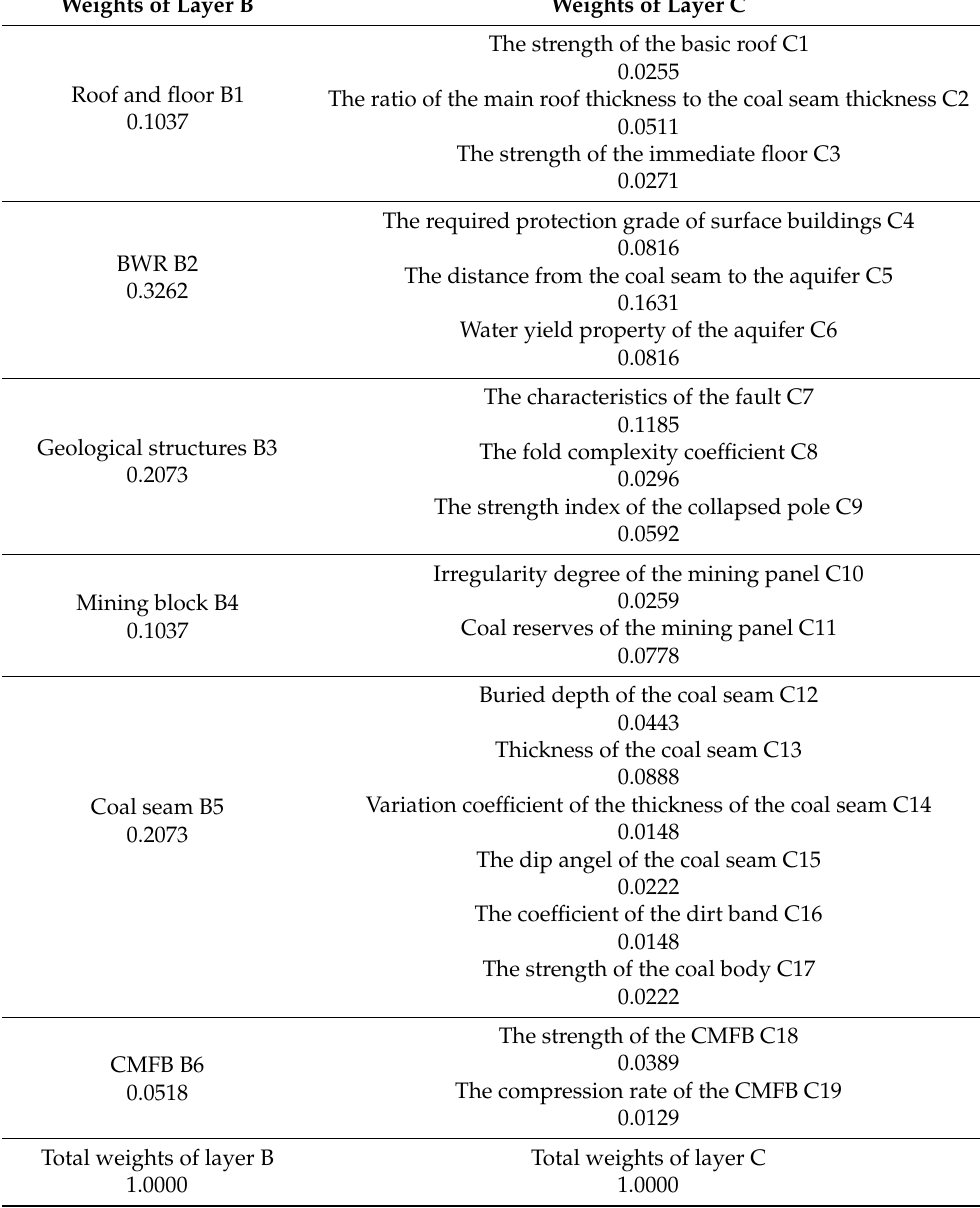
Table 6. Weight distribution of different influencing factors of CECB